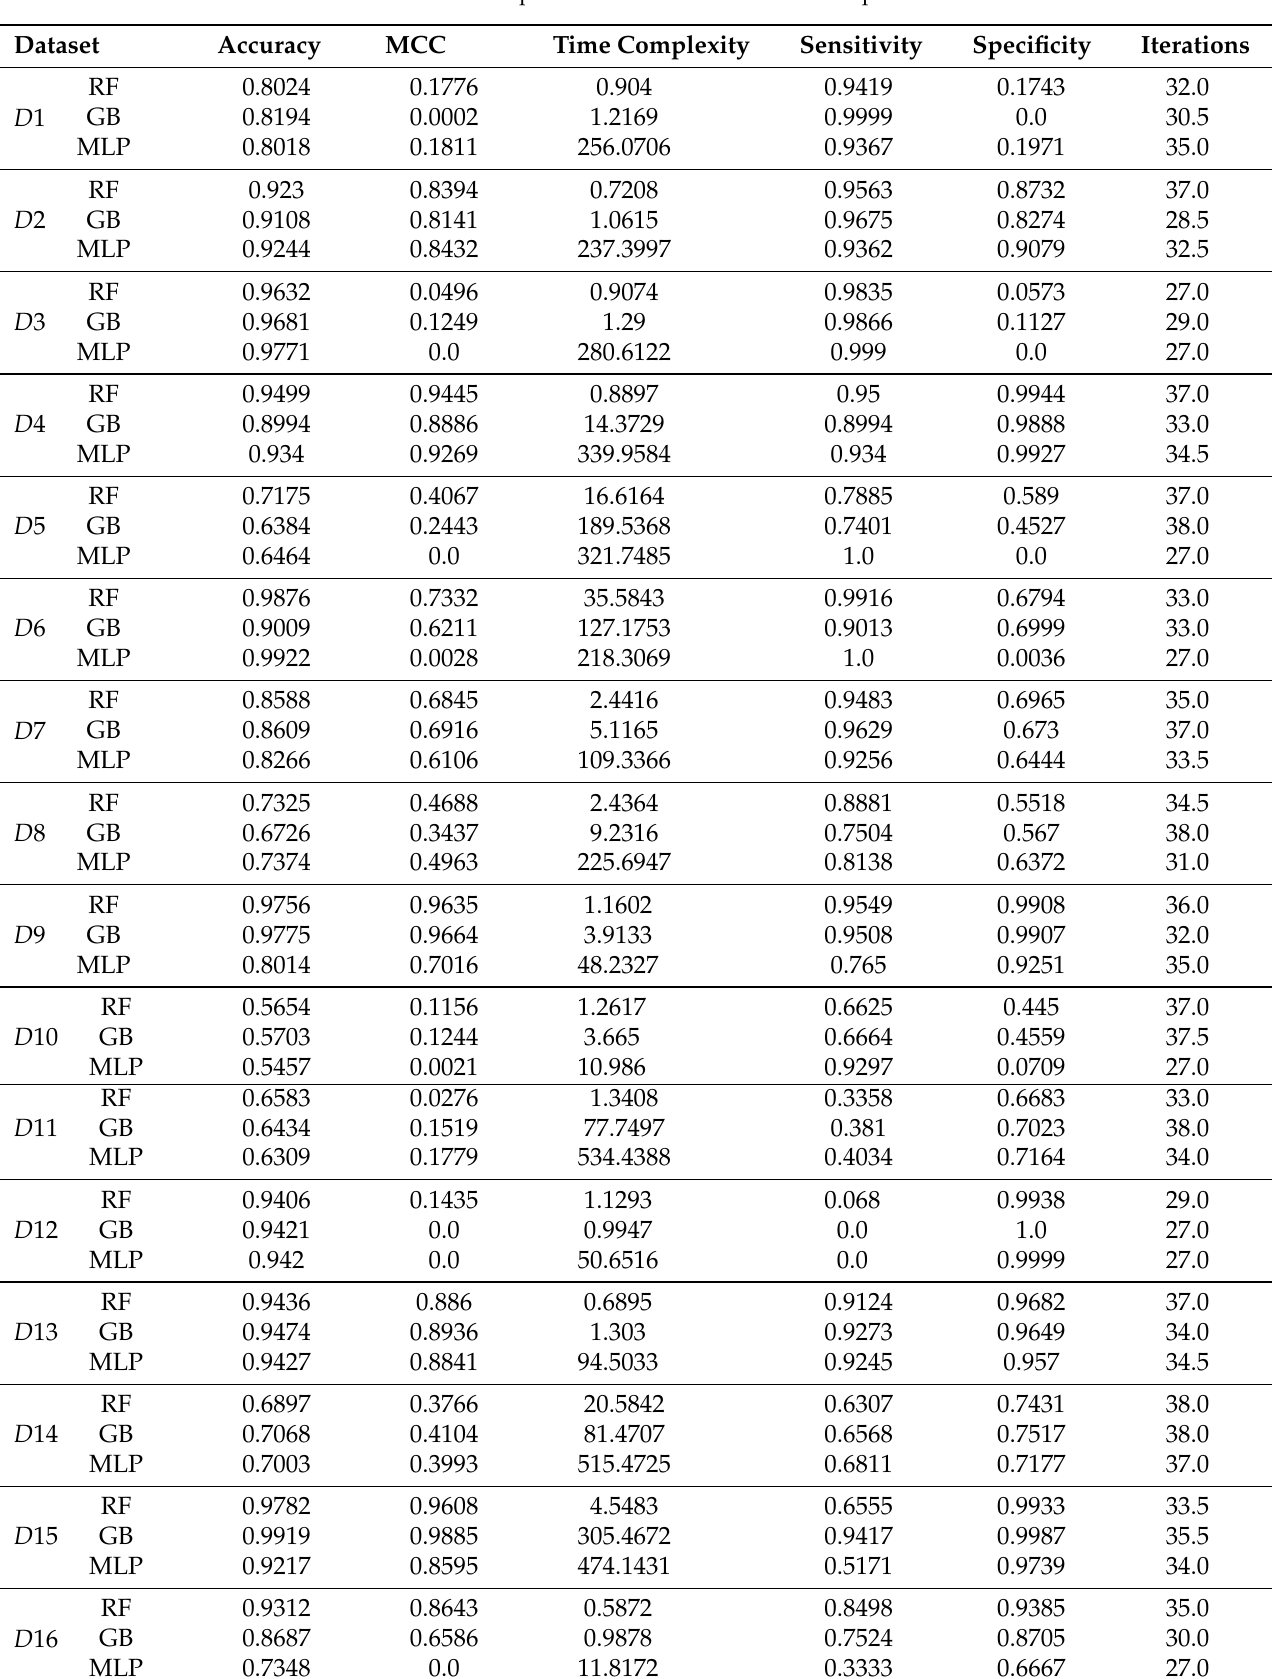
Table 7. Medians of response variables for RHOASo in Experiment